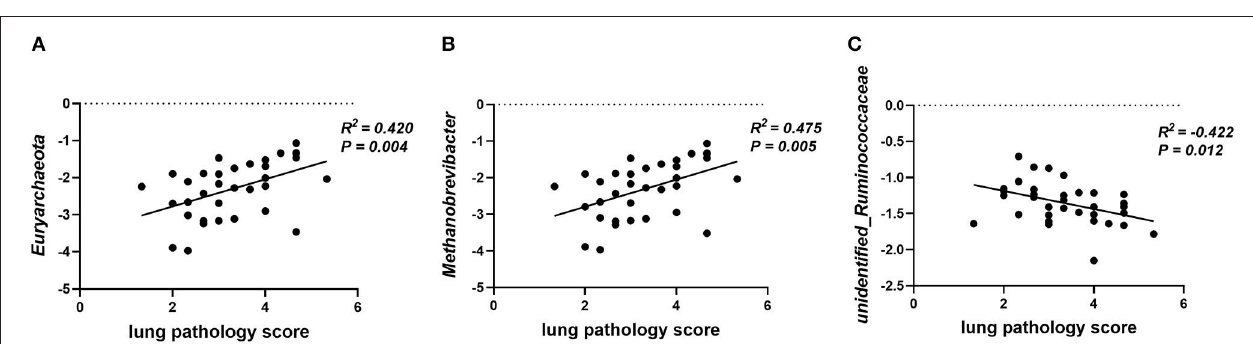
FIGURE 7 | The histogram and heat map of the relative abundance of microorganisms at phylum level and genus level. (A) 16S rRNA gene analysis reveals that there are differences in the phylum level of three bacterial in the four groups. (B) 16S rRNA gene analysis reveals that there are differences in the genus level of six bacterial in the four groups. (C) Heat-map of species abundance based on top 20 genera clustering (vertical clustering). Different color means the different relative abundance of the genus in all the four treatments.